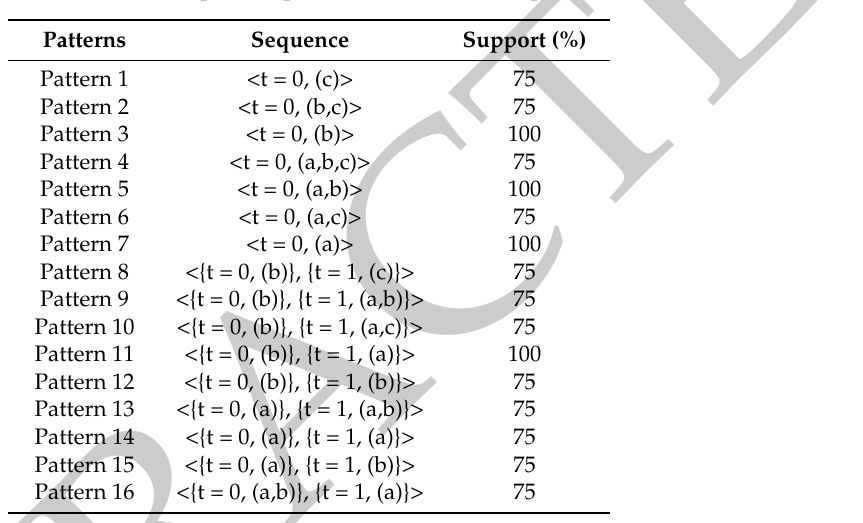
Table 3. The extract of the frequent sequential models with temporal information. Patterns